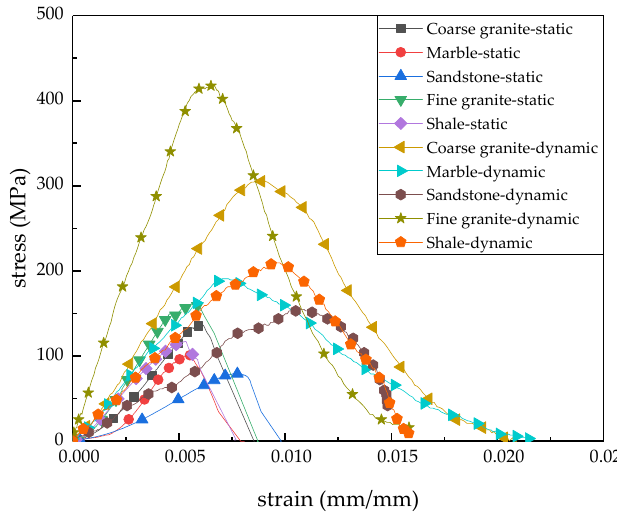
Figure 2. Stress–strain curves with different loading modes.